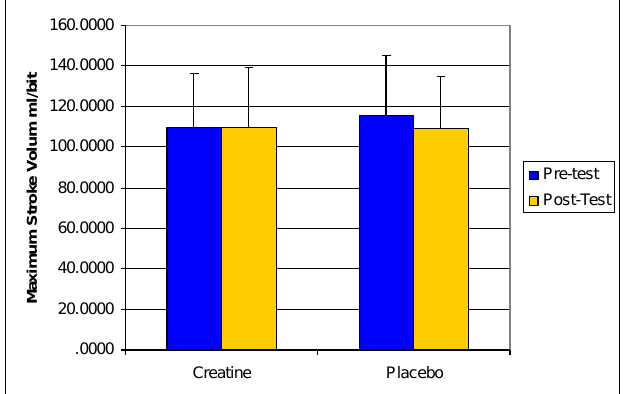
Figure 1. Creatine intervention on the Maximum Stroke Volume after five weeks supplementation is presented in this graph.